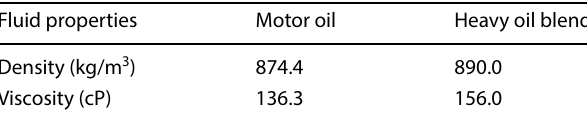
Table 4 Oil properties at 22 °C Fluid properties